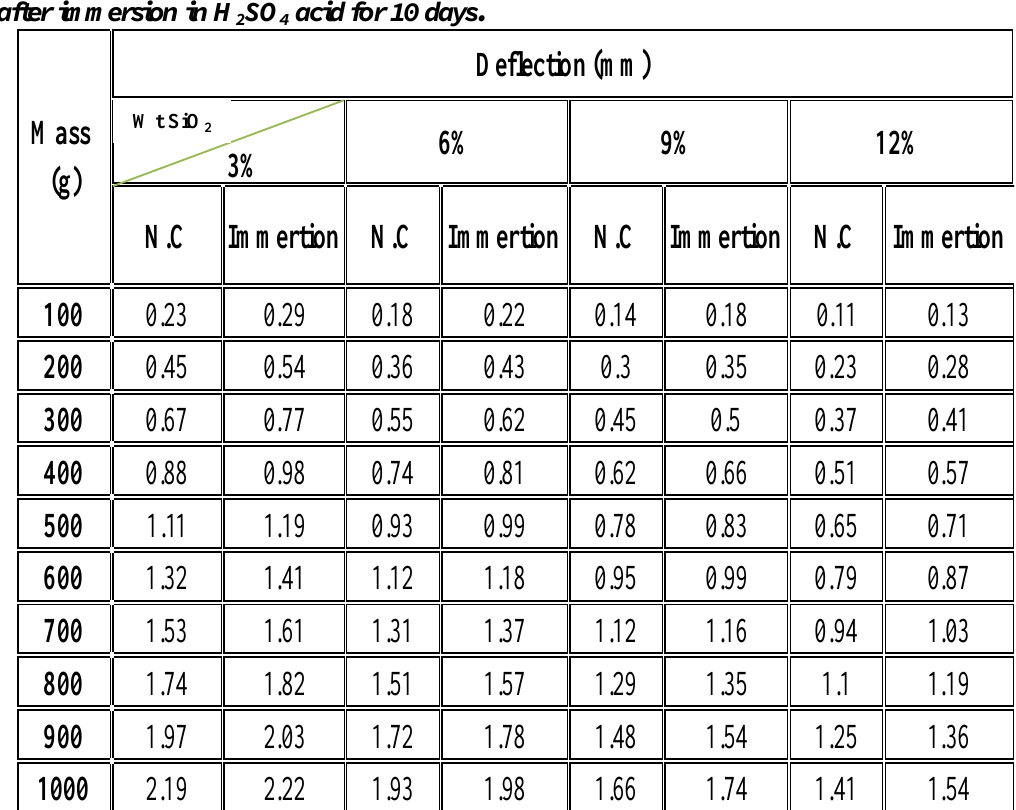
in normal conditions and 2